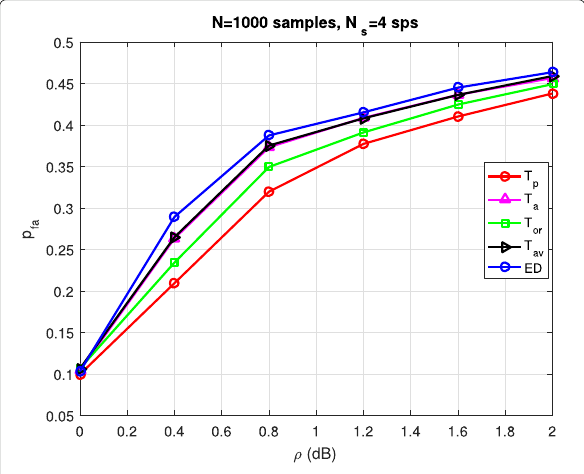
( ˆ σ 2 ) , , f ˆ σ 2 w w w